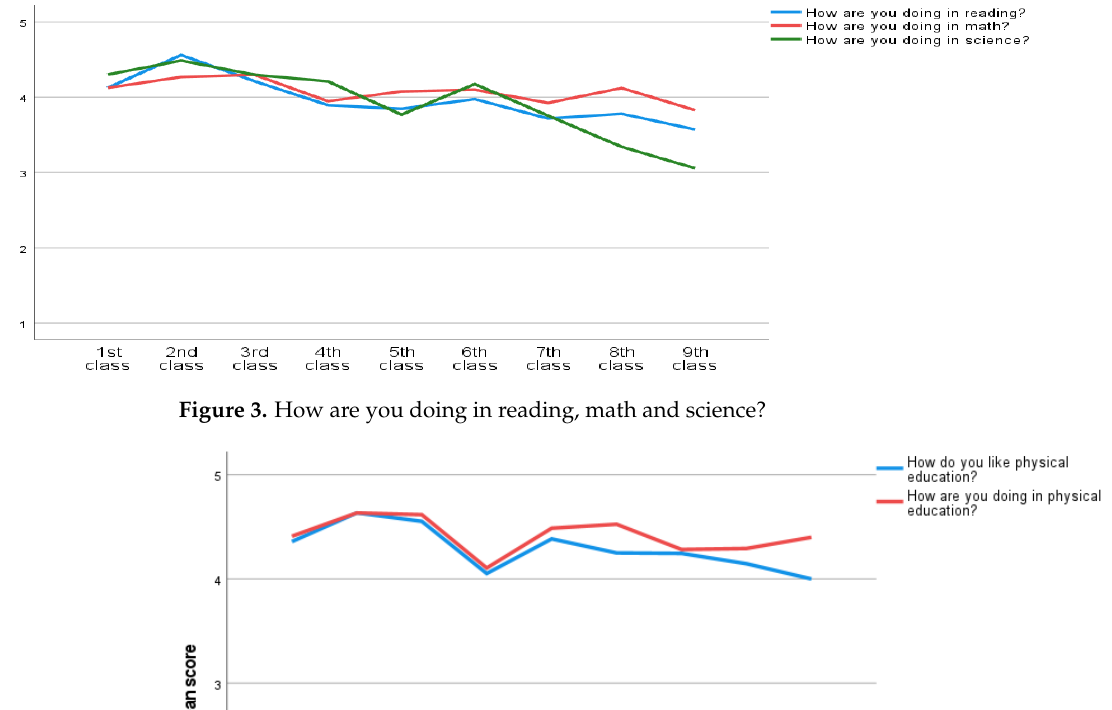
Figure 3. How are you doing in reading, math and science?